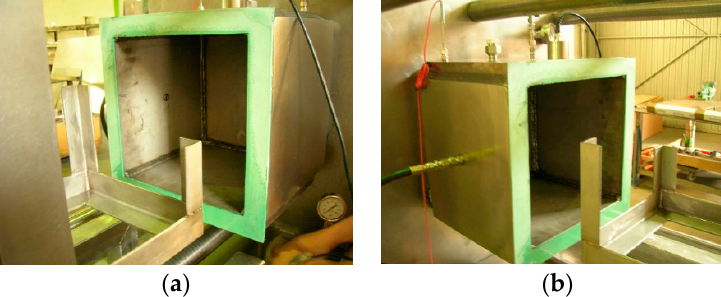
Figure 2. ( a ) Details of stainless steel chamber; ( b ) Description of what is contained in the second